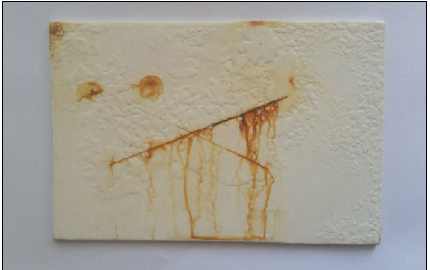
Figure 5. PA7 after 1000h under the salt spray test before adding more adhesion promoter and surface agent. merges in the polymer matrix. The adhesion promoter, without reduction of hardness, may improve the flexibility of the coating but it is dependent on the coating Table 4. Mechanical results of sample PA7 as a final formulation No.